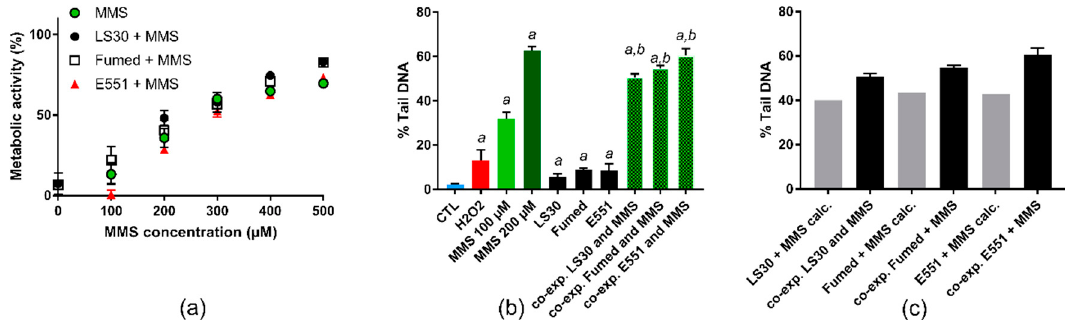
Figure 7. Cyto- and genotoxicity on RAW264.7 cells of MMS or co-exposure to MMS and SiO 2 . ( a ) Cell metabolic activity, assessed via the WST1 assay; ( b ) DNA strand breaks and/or alkali-labile sites assessed via the alkaline comet assay in RAW264.7 cells exposed to 10 µg/mL SiO 2 . Positive control: H 2 O 2 (250 µM); ( c ) comparison of experimental results (level of DNA damage in cells co-exposed to MMS and SiO 2 ) and calculated values (level of DNA damage in cells exposed to MMS + level of DNA damage in cells exposed to SiO 2 ) WST1: mean ± standard deviation of five independent experiments (n = 5); comet assay: mean ± standard deviation of two independent experiments with three slides per experiment (n = 2). Statistical significance, a : p < 0.05, exposed vs. CTL (untreated cells), b , p < 0.05, co-exposed to SiO 2 particle and MMS vs. exposed to the respective SiO 2 particle.